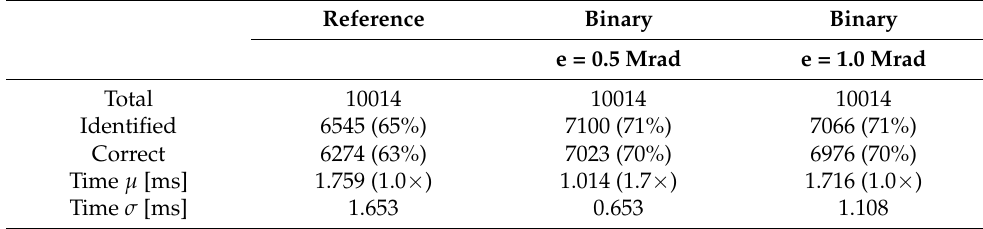
Table 6. Comparison of star identification algorithms, FOV = 8°.